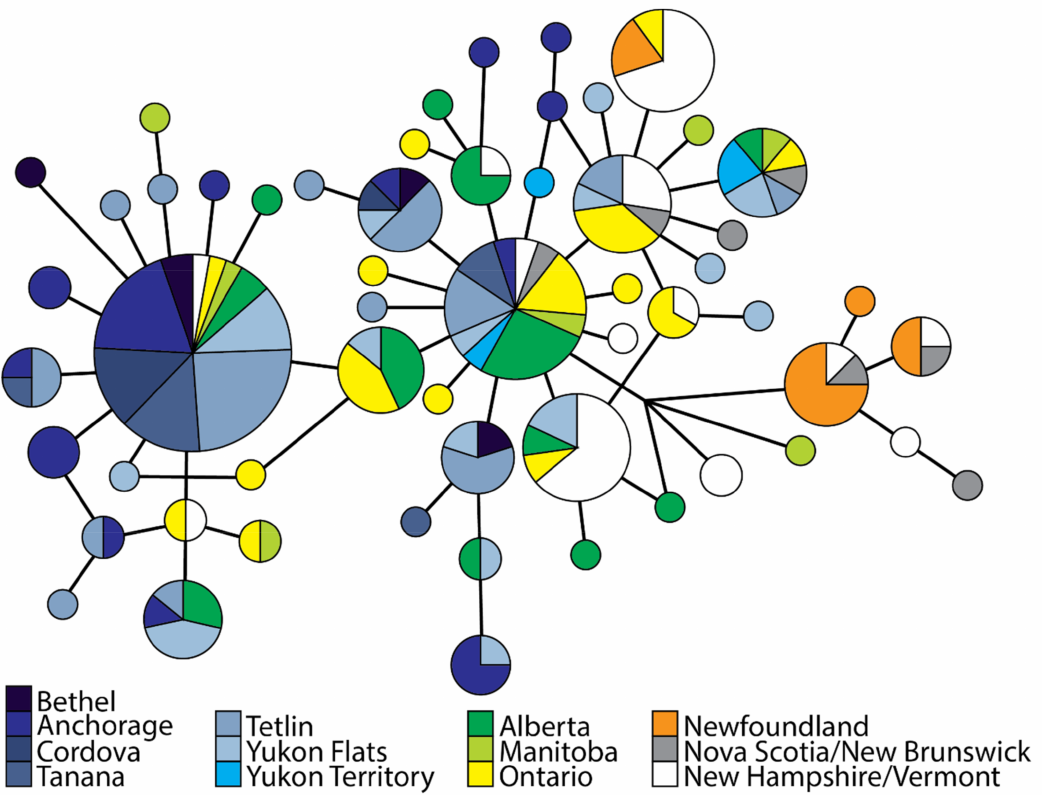
Figure 3. Unrooted mitochondrial DNA haplotype median-joining network for rusty blackbirds. Size of circle is proportional to the frequency of each haplotype